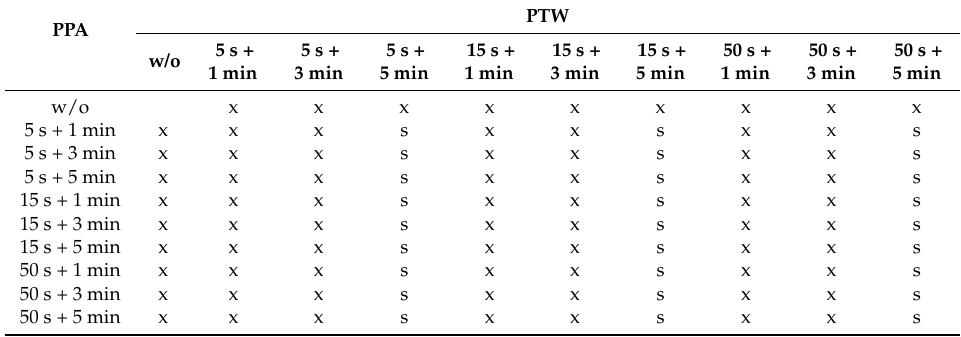
Table 2. Investigated pre- and post-treatment times of PTW (plasma-treated water) and PPA (plasma-processed air) applied separately and in